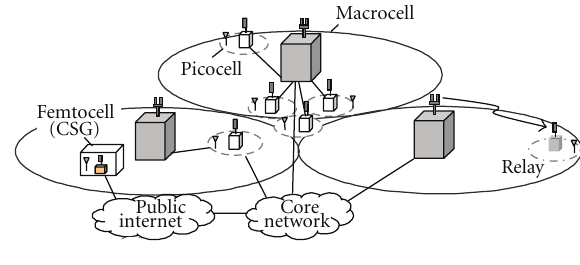
Figure 1: Configuration of heterogeneous